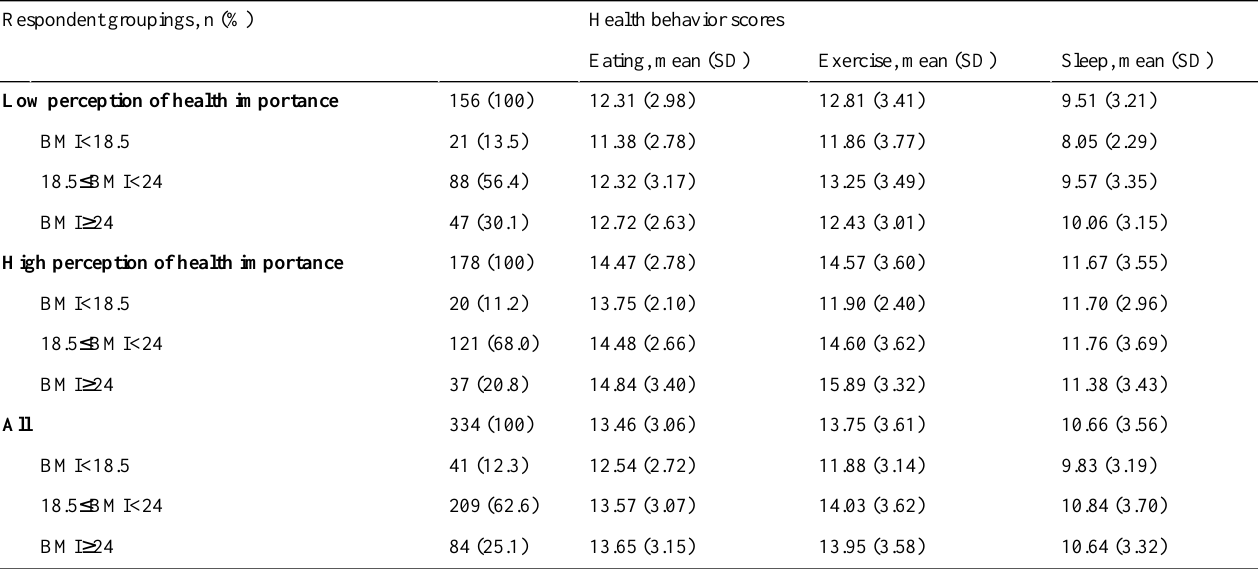
Table 1. Descriptive summary for each health behavior by perceived importance of health and BMI.